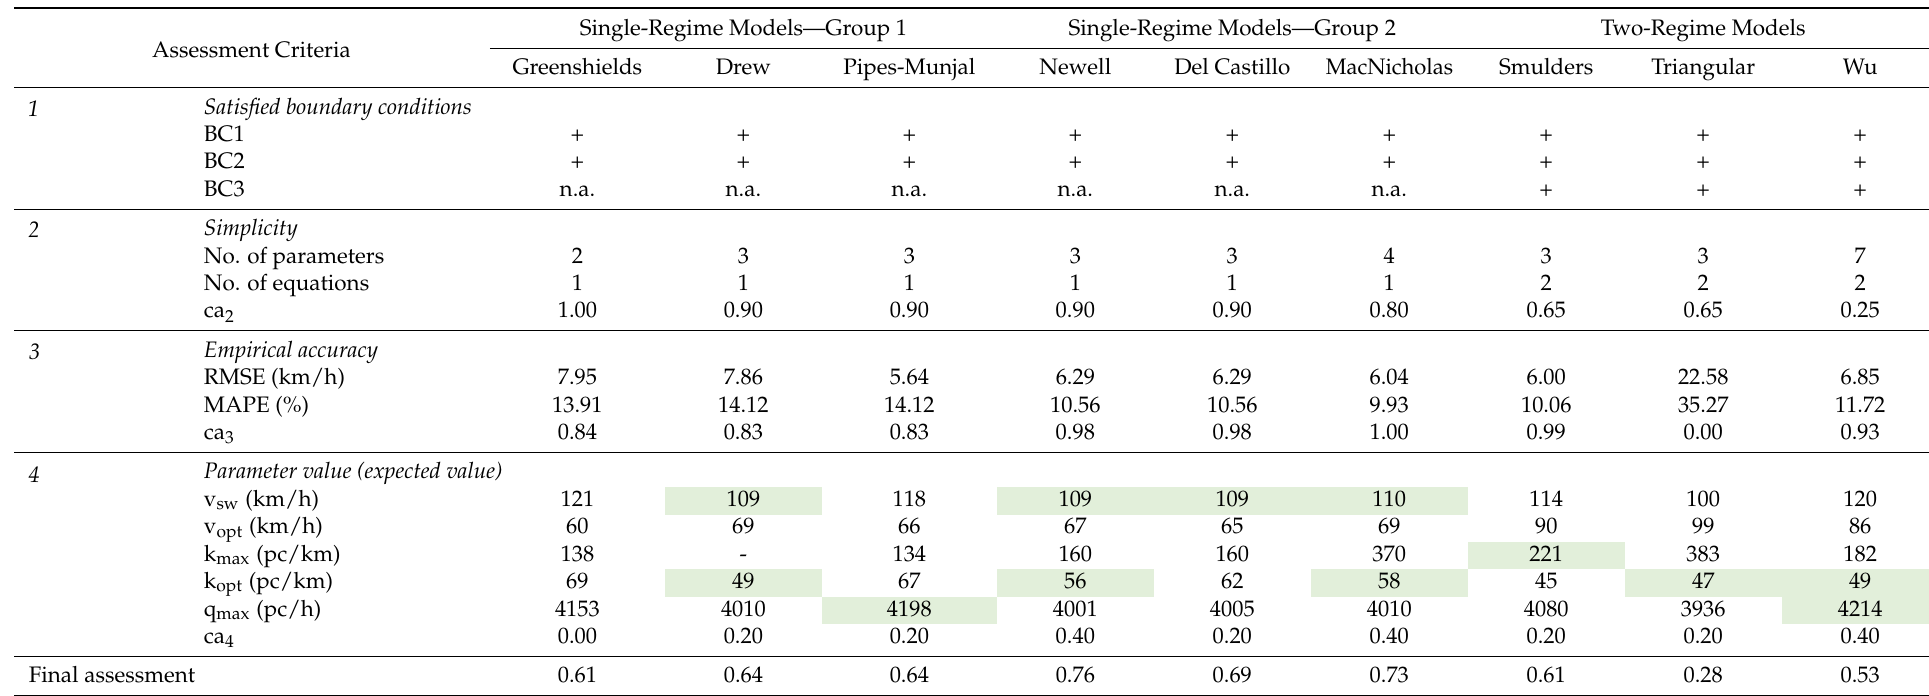
Table 5. Assessment and comparison of traffic flow models for the field